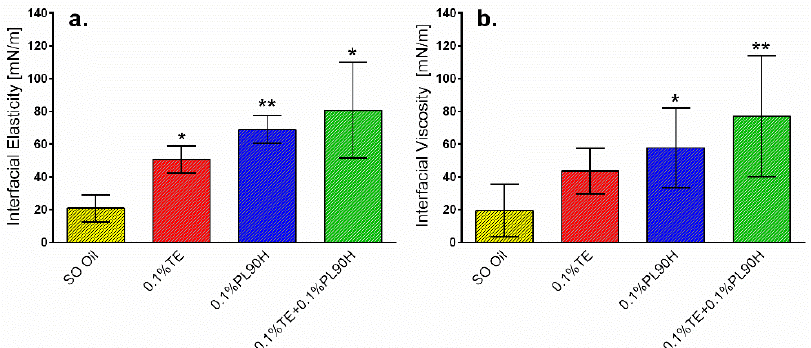
Figure 3. Interfacial elasticity ( a ) and viscosity ( b ) of 0.1% PL90H, 0.1% TE and PL90H + TE dispersed in sunflower oil (Mean ± SD, n = 6). statistically significant, * p < 0.05; ** p < 0.01 vs. sunflower oil (reference).